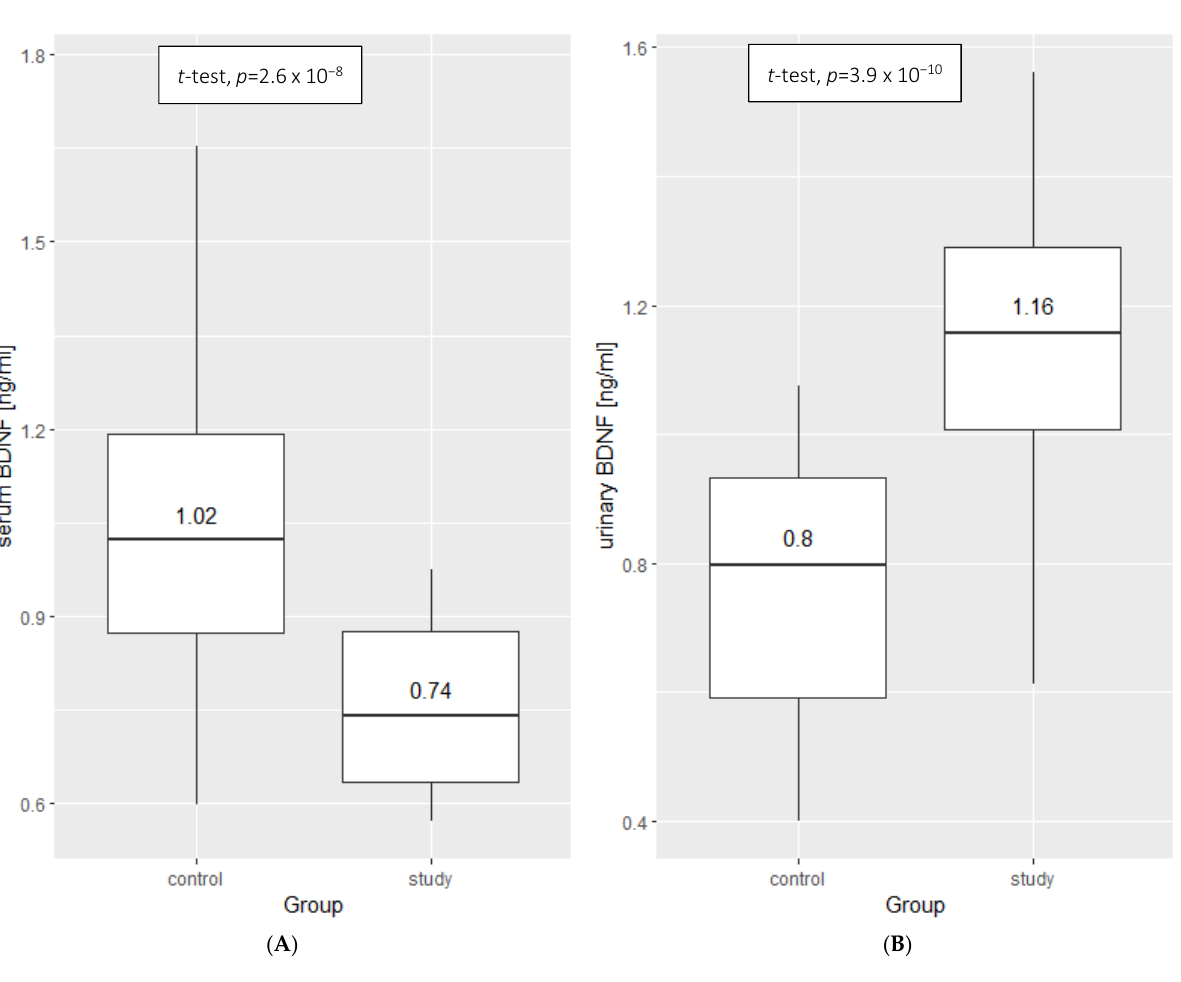
Figure 1. Comparison of BDNF concentration in serum ( A ) and urine ( B ) between the control group and the study group (Student’s t -test for independent samples). Additional data: mean ± standard deviation—( A ): control: 1.02 ± 1.06, study: 0.74 ± 0.76; ( B ): control: 0.80 ± 0.77, study: 1.16 ± 1.14.